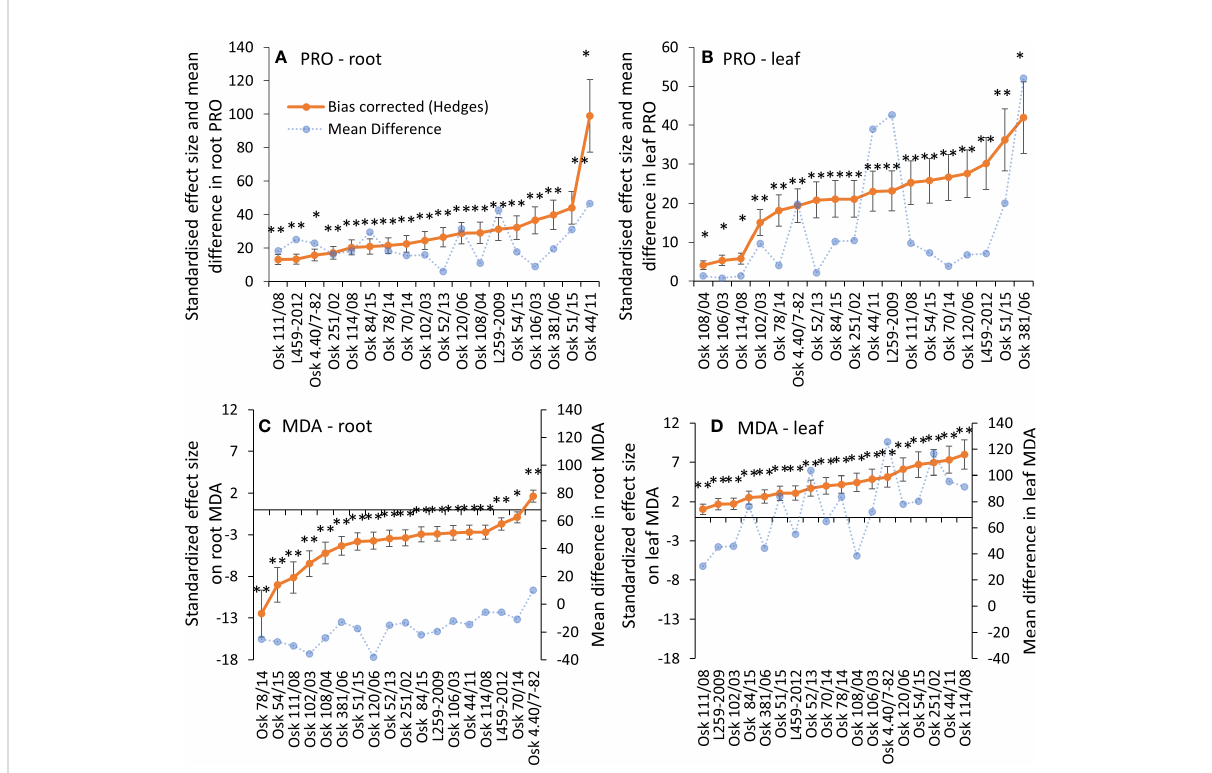
FIGURE 2 Hedges bias-corrected treatment effect size (with con fi dence interval) and the mean difference between PEG-induced drought and control treatments for proline and MDA contents in roots (A, C) and leaves (B, D) of 18 genotypes of winter wheat seedlings. Signi fi cant effects of PEG induced drought are marked with asterisks (* p< 0.05, 0.01, ** p< 0.001), and ns stands for non-signi fi cant (p >